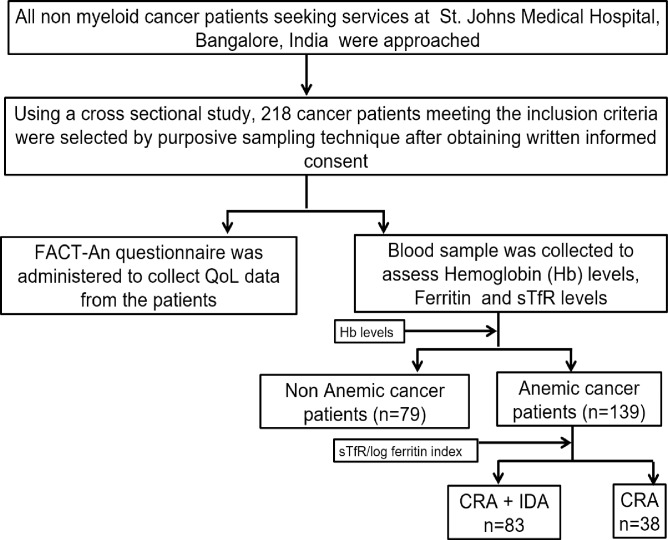
Schematic representation of the study design Using gender adjusted WHO norms [13] patients were divided into anemic and non anemic categories.Anemic cancer patients were further subdivided into those having only cancer related anemia (CRA) or those having cancer related anemia patients combined with iron deficiency anemia (CRA+IDA).